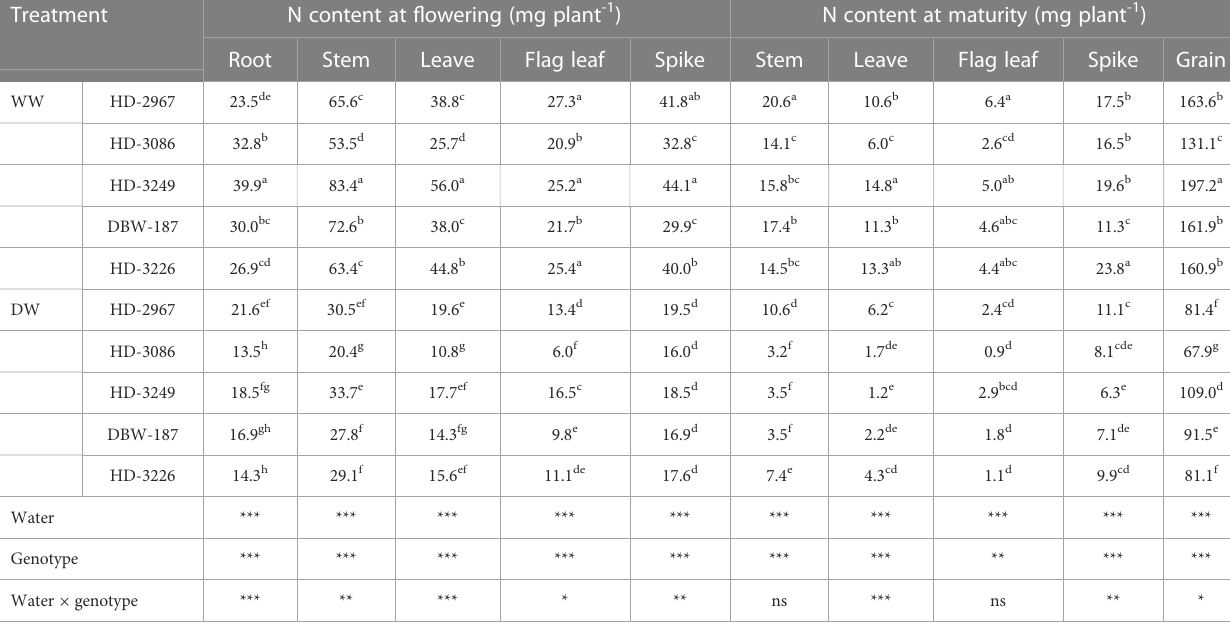
Data are the mean of three replicates for each genotype and water treatments. Values in a column followed by the different letters are signi fi cantly different at p<0.05 as determined by Tukey ’ s honestly signi fi cant difference test among the varieties. Spike at maturity is glumes + awns without grain. For ANOVA results, *p<0.05, **p<0.01, ***p<0.001, and ns not signi fi cant.